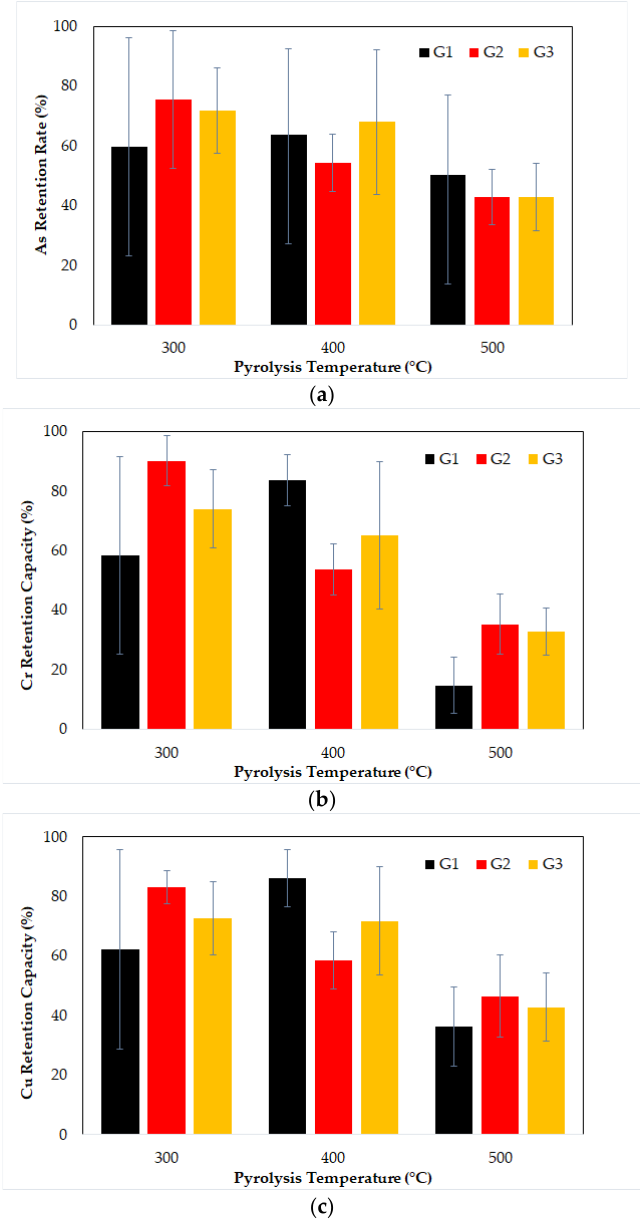
Figure 4. Retention capacity of As ( a ), Cr ( b ), and Cu ( c ) in biochar prepared at different particle sizes: 0.85 < G1 < 1.4 mm, 1.4 < G2 < 2 mm, and 2 < G3 < 3.35 mm, and different pyrolysis temperatures (300, 400, and 500 °C).